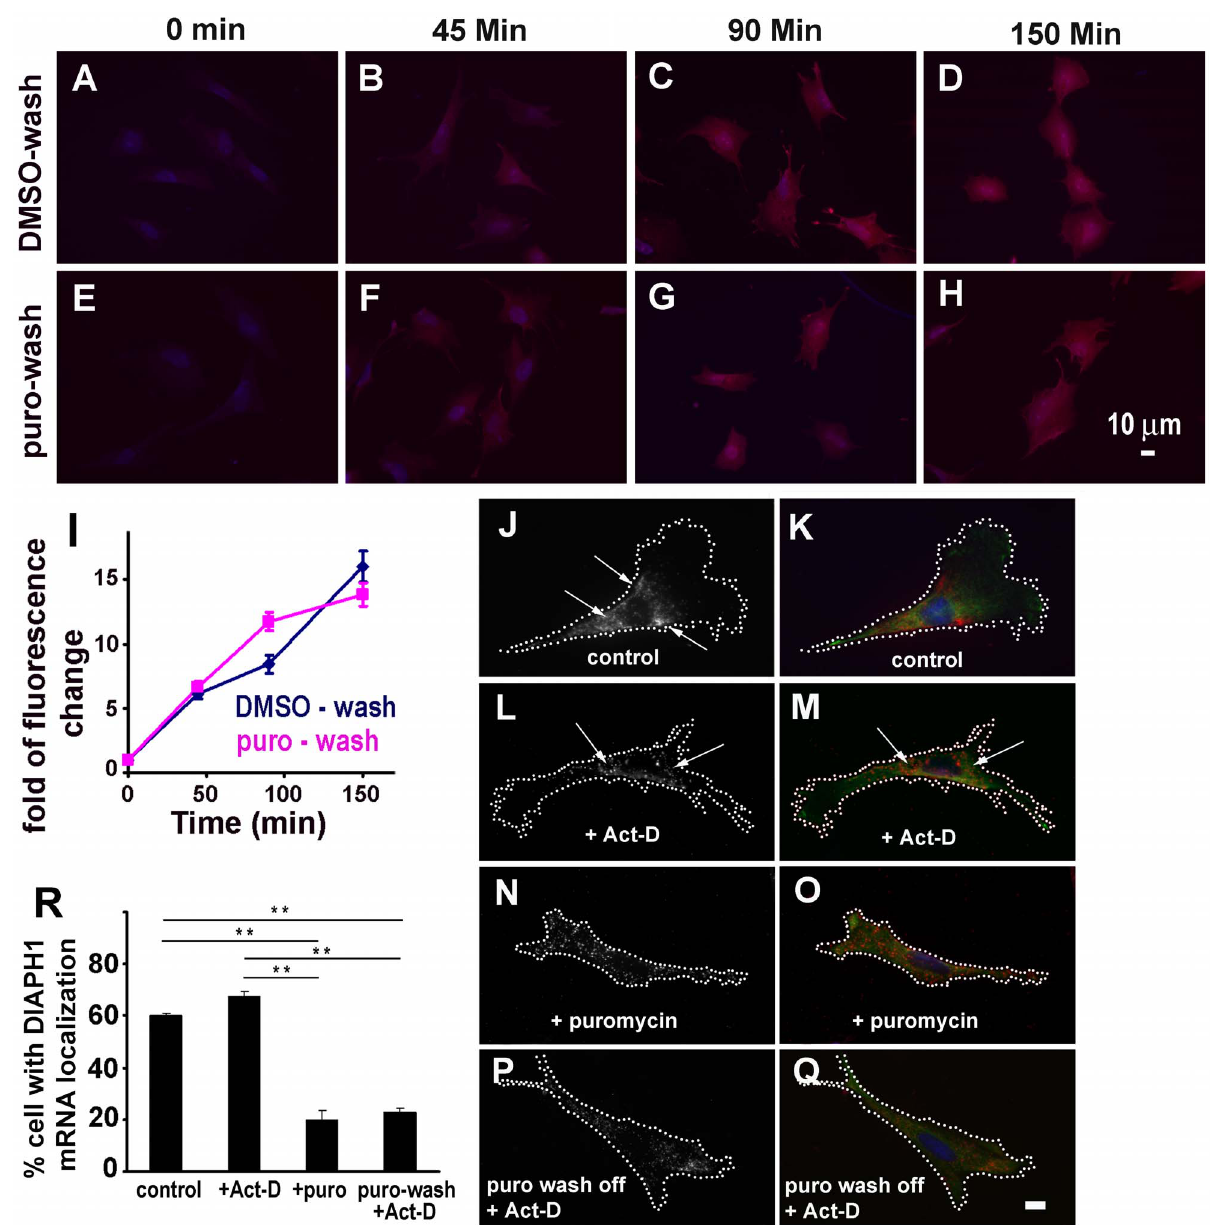
Figure 1. Delocalized DIAPH1 mRNA cannot be re-localized. A–I . Resumption of translation after puromycin wash-off. CEF grown on cover slips were treated with DMSO or 10 m g/ml of puromycin in methionine-free DMEM for 90 min and then followed by 2 6 10 min washes with Hank’s balanced saline. Newly synthesized proteins were detected using the Click-iT kit (Invitrogen) as described in Materials and Methods. A-H . Representative cells showing the fluorescence signal (red) of the newly synthesized proteins. I . Quantitative results of newly synthesized proteins indicate resumption of protein translation after puromycin wash-off (fluorescence per cell, normalized to that of time zero, representing , 80 cells at each time point per condition from two independent experiments). J–Q . Representative cells for DIAPH1 mRNA distribution after the indicated treatments. Images in the left column are gray scale for better display the DIAPH1 mRNA signal. CEF were transfected with HA-tagged DIAPH1 expression plasmid for 24 hr and then treated with DMSO (control, J & K ), or 5 m g/ml of transcription inhibitor actinomycin D (Act-D) ( L & M ), or 10 m g/ml of puromycin (N & O) for 90 min before fixed for FISH detection of DIAPH1 mRNA localization. In P & Q , the cells were first treated with 10 m g/ml of puromycin for 90 min then followed by 2 6 10 min washes with growth medium plus 5 m g/ml of Act-D then incubated in normal growth medium for 90 min before fixed for FISH and DIAPH1 mRNA localization score. Note that Act-D at this concentration did not affect the normal localization of already transcribed DIAPH1 mRNA. In right column, Red: DIAPH1 mRNA; green: HA-tagged Dia1 protein; Blue: nucleus. Dotted lines show cell border. Arrows indicate localizing DIAPH1 mRNA molecules. Scale bar: 10 m m. R . Quantitative results of DIAPH1 mRNA localization. 300–500 cells were scored for each condition. Error bars: sem. n=3. **. P , 0.01. doi:10.1371/journal.pone.0068190.g001 control 5 9 -cap mediated translation of mRNA [43–45]. The IRE is encoding proteins involved in iron metabolism [46;47]. At low an RNA stem-loop which naturally exists in the 5 9 -UTR of mRNA level of iron, an IRE binding protein (FP) binds to the IRE and